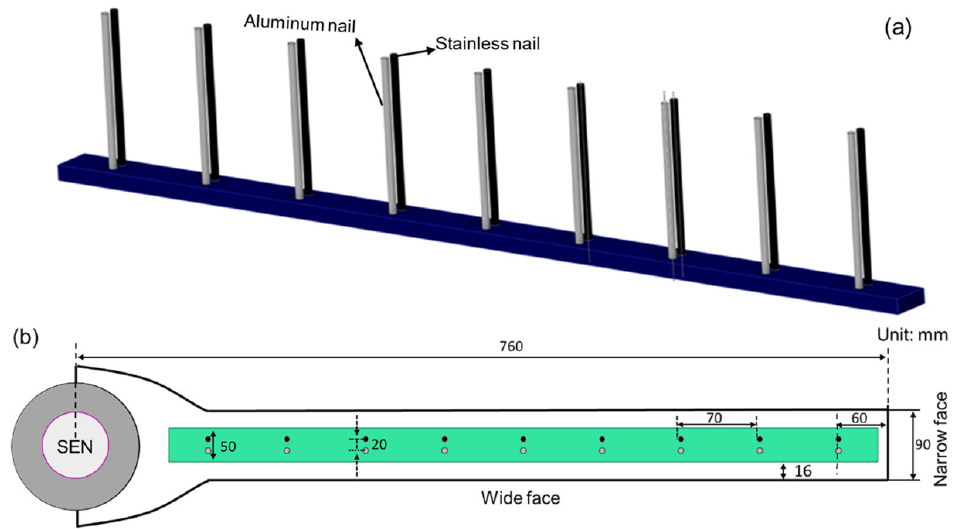
Figure 17. Description of the nail board and position for dipping tests. ( a ) Nail board and ( b ) position for dipping tests.